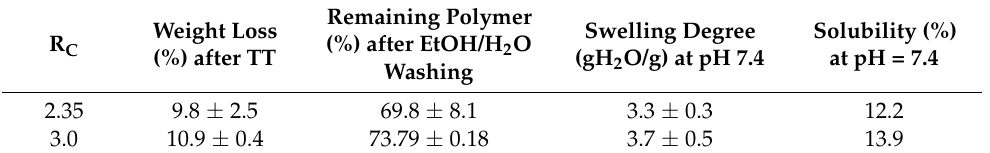
Table 6. Weight loss for thermal treatment at 120 °C for 4 h and stability of nanofibers for R C = 2.35 and 3.